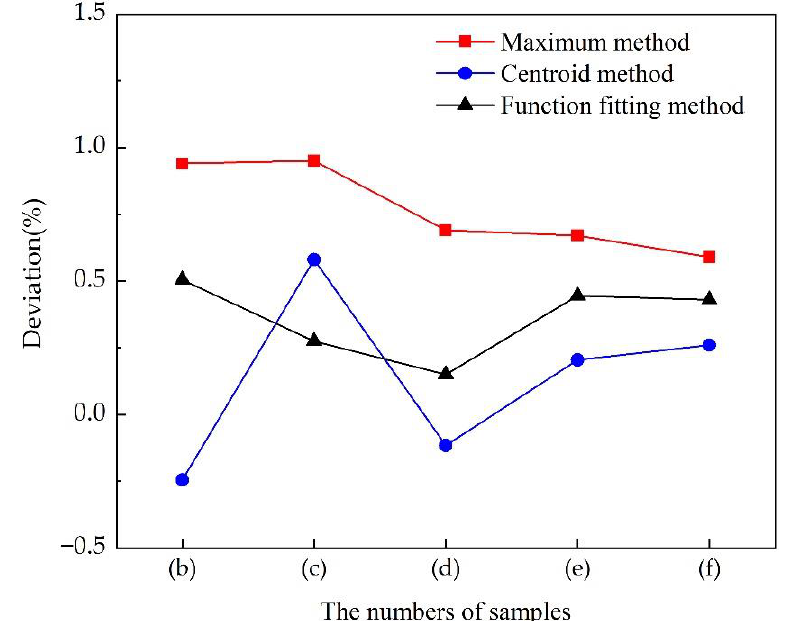
Figure 11. The deviations of locating abrasion with three methods.